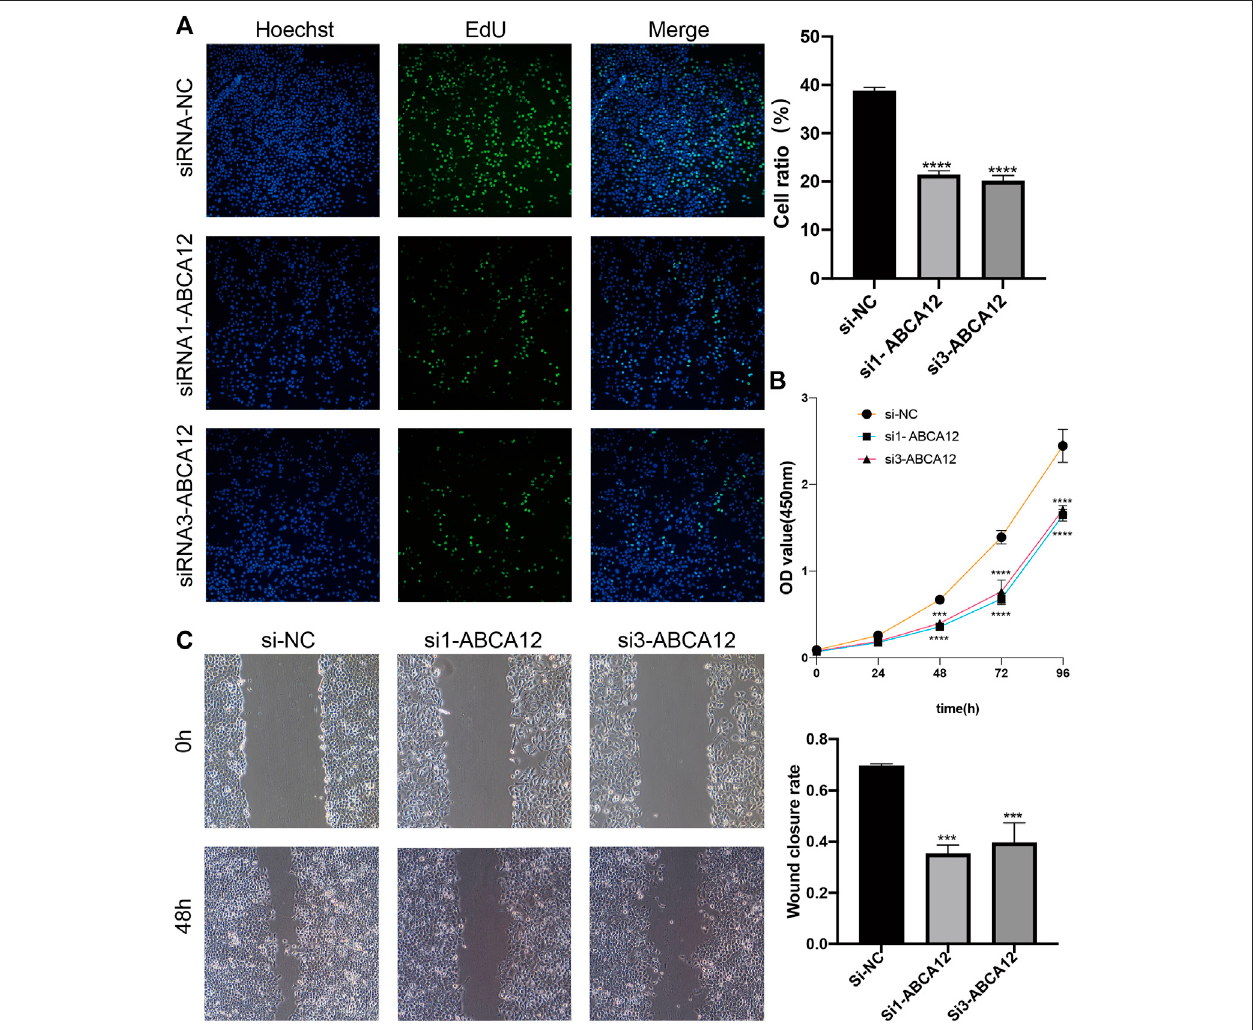
FIGURE 4 | Changes in proliferation and migration of SW1990 cells after ABCA12 knockdown. (A) EdU experiments showed that the proliferation ability of pancreatic cancer cells was signi fi cantly reduced after ABCA12 knockdown. (B) CCK-8 assay showed that the proliferation ability of pancreatic cancer cells was reducedafter ABCA12 knockdown. (C) Scratchhealingexperimentsshowedthatthemigrationabilityofpancreaticcancercellswassigni fi cantlyreducedafter ABCA12 knockdown.